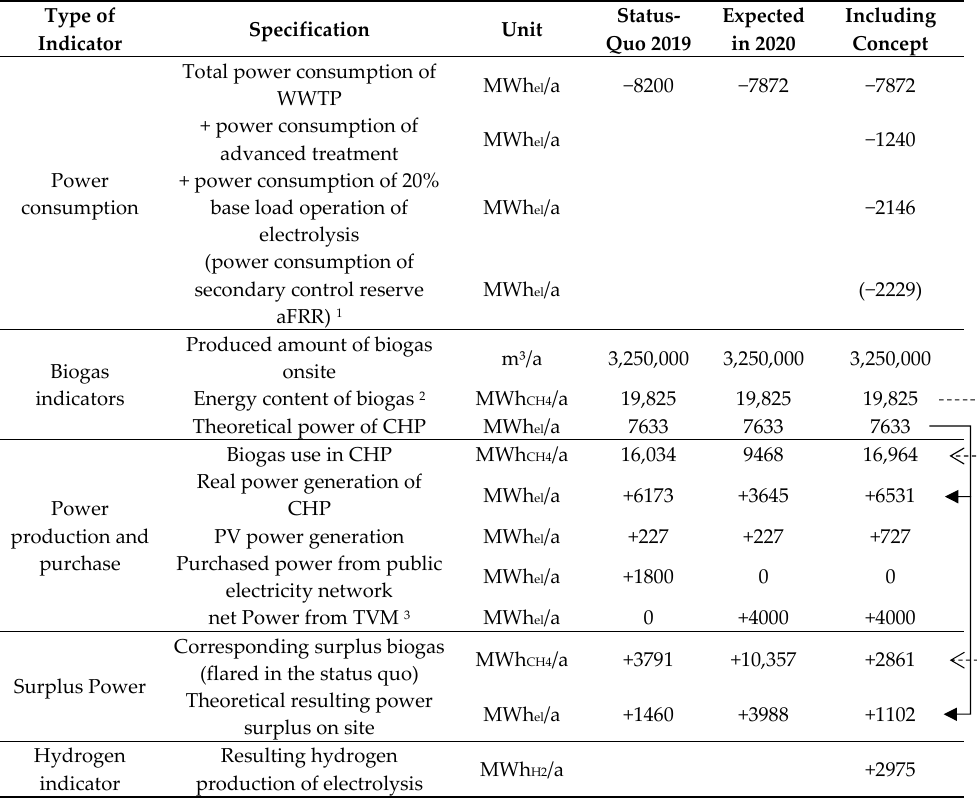
Table 4. Simplified energetic situation based on the annual average values of the WWTP Mainz before and after the start of the operation of the sludge incineration plant and the implementation of the innovative concept.